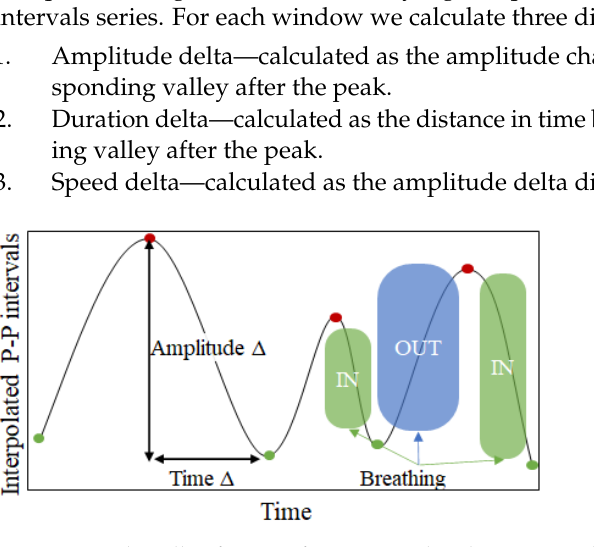
Figure 8. Peak–valley features from interpolated P-P